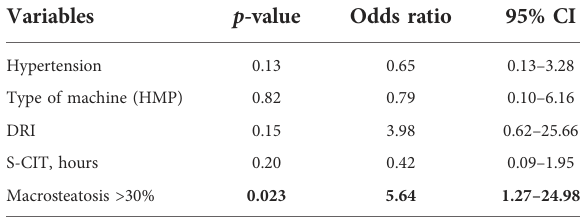
TABLE 3 Multivariate analysis of the donor and grafts risk factors predicting the negative events.